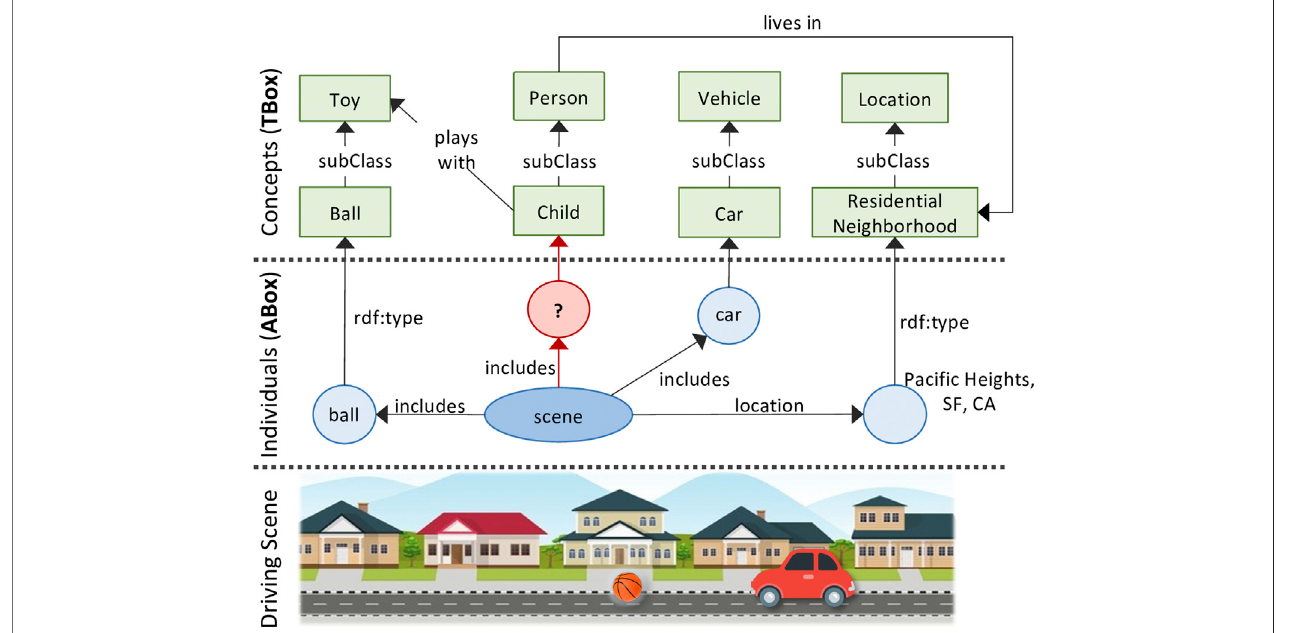
FIGURE 1 | Example scene KG with potentially missing